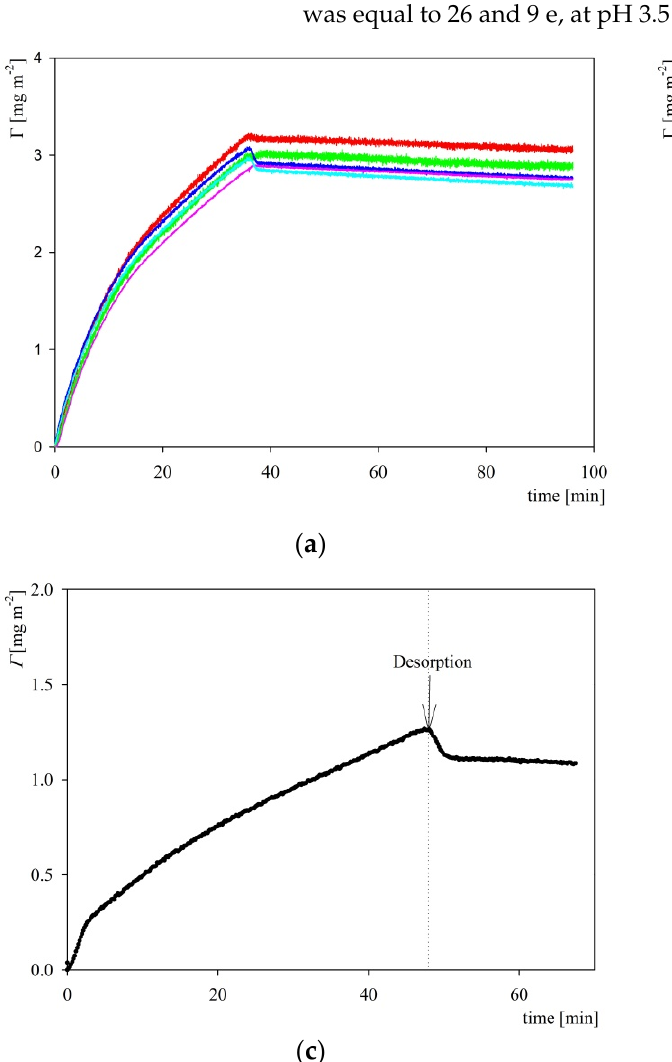
Figure 8. Kinetics of S1R adsorption/desorption expressed as the dependence of the coverage on the time; adsorption conditions pH 7.4 (PBS), bulk protein concentration 5 mg L ‐ 1 , flow rate 8.3 × 10 ‐ 4 cm 3 s ‐ 1 . Part ( a ) QCM measurements, silica sensor; 150 mM. Part ( b ) QCM measurements, silica sensor; 10 mM. The coverage was calculated using the Sauerbrey equation for the overtones 3 (red), 5 (green), 7 (blue), 9 (violet), 11 (light blue). Part ( c ) OWLS measurements, silica sensor, 10 mM, NaCl.